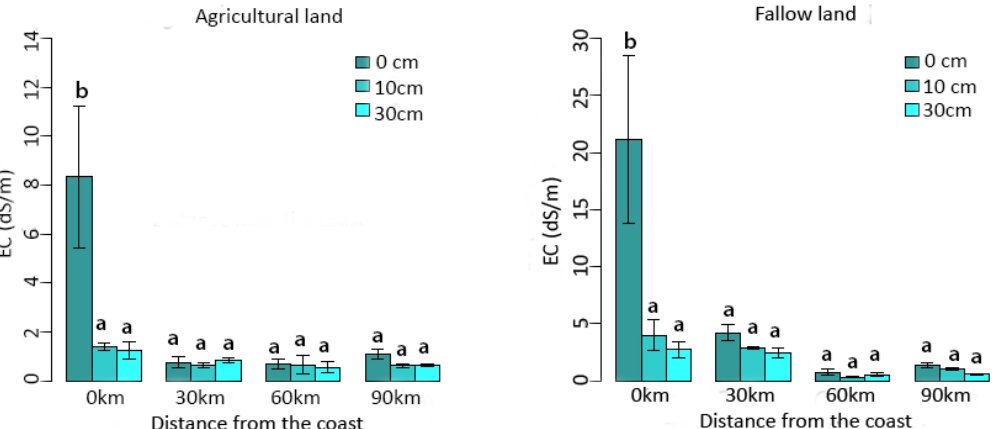
Fig. 3: Bar graphs showing the EC differences along a distance gradient from coastline between agricultural and fallow land in different soil depths. Different letters above the error bars denote significant differences among the groups based on Tukey’s post-hoc test at α≤0.05 where homogeneous letter subsets are expressing non-significant difference